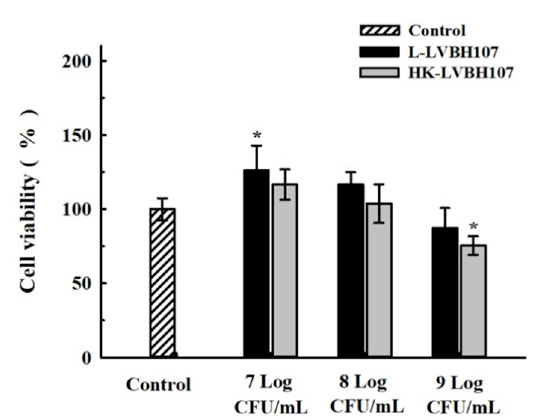
Figure 4. Effect of L. mesenteroides LVBH107 on the cell viability of RAW264.7 cells. * p < 0.05, compared to control group. Actual p -values are shown in Table S2.